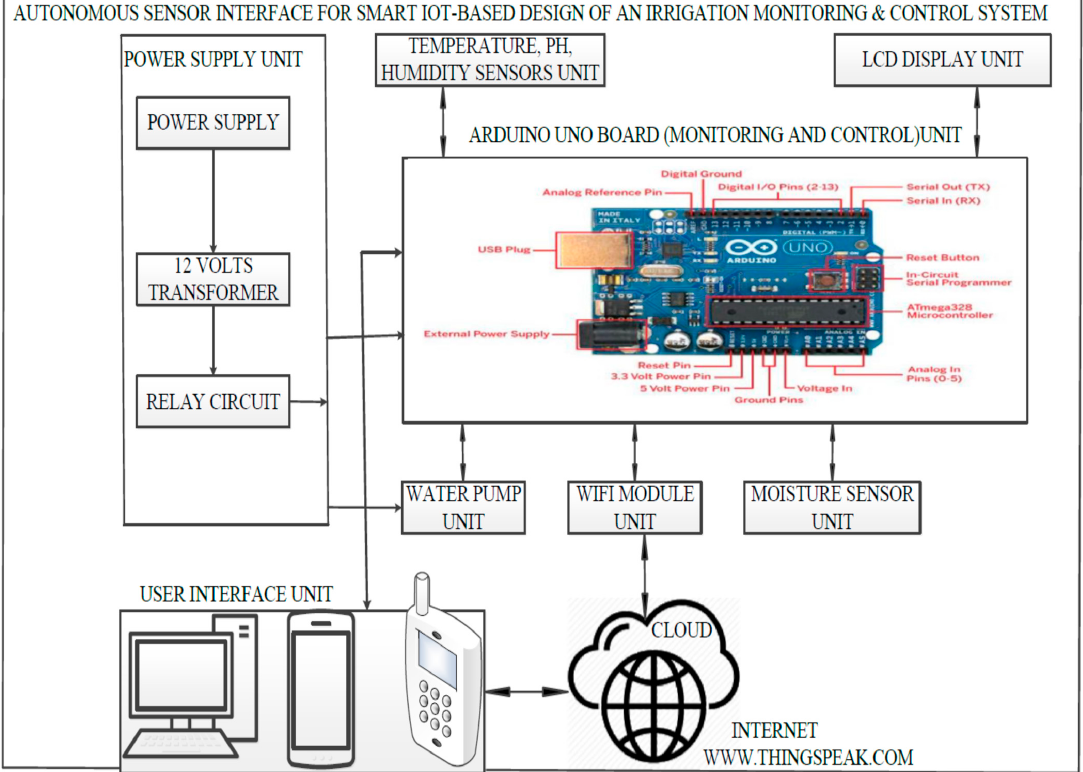
Figure 1. Figure 1. Low-cost sensor interface for smart IoT-based irrigation monitoring and control system architecture.